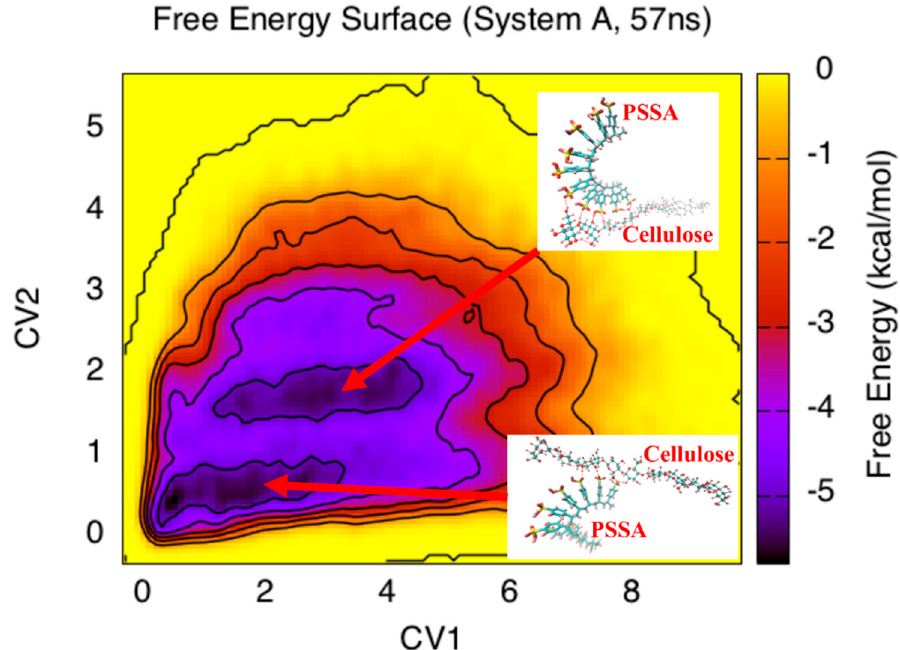
Figure 5. The 2D free energy surface contour plot for system A, involving the interaction of DP 10 neutral PSSA and DP 10 cellulose in water. CV1 and CV2 represent the number of hydrogen bonds formed between them.